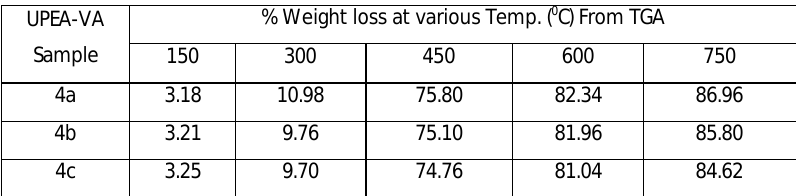
Table Table ––22 TGA of unreinforced cured sample of UPEA-VA resin